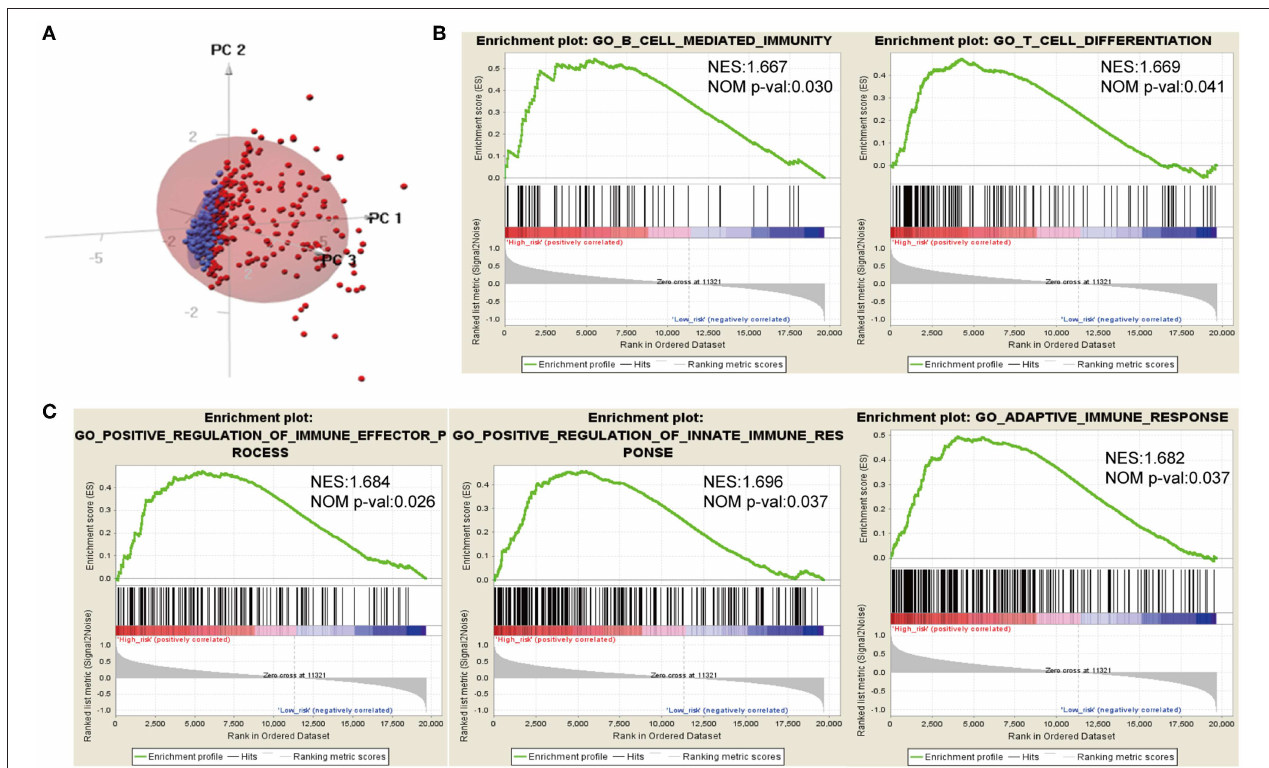
FIGURE 5 | Different immune phenotypes between high- and low-risk groups in TCGA cohort. (A) Principal components analysis of IDH1-associated immune genes between high- and low-risk groups. Blue color indicates low-risk patients, and red color represents high-risk patients. (B,C) Gene set enrichment analysis for comparing immune phenotype between high- and low-risk groups. Significant enrichment of five immune-related GO terms in high-risk group. FDR, false discovery rate; NES, normalized enrichment score.